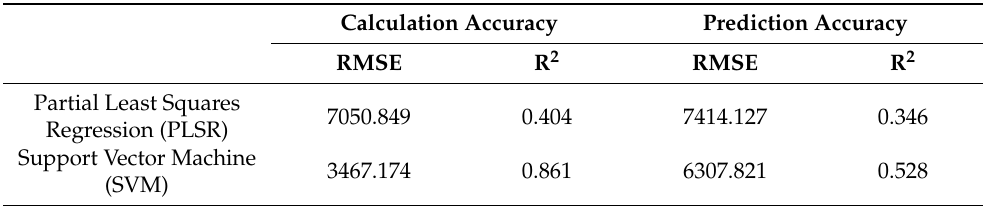
Table 3. Accuracy assessment for the prediction models. RMSE: root mean square error and R 2 : determination coefficient.